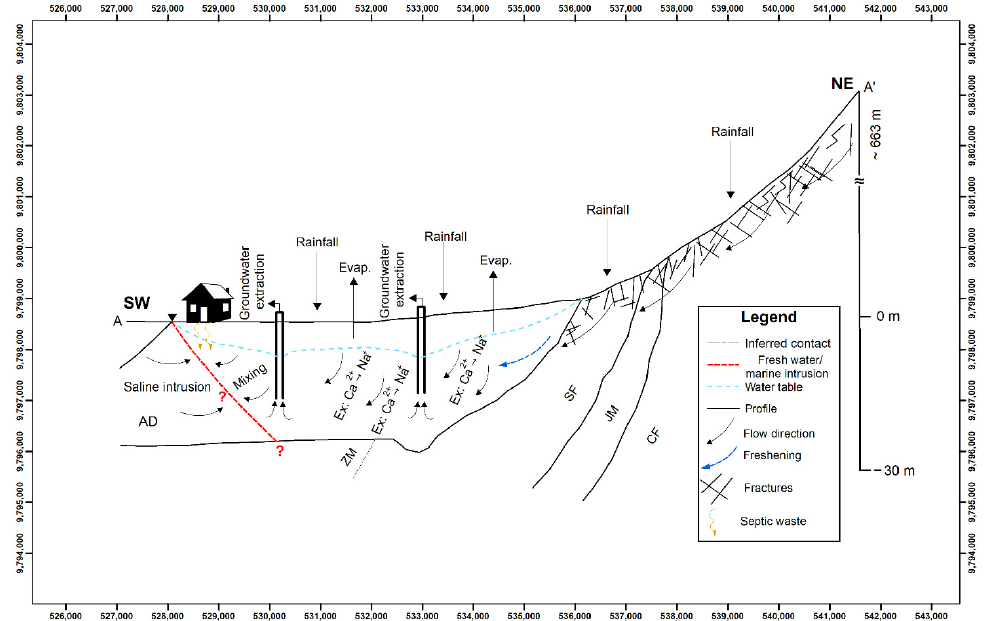
Figure 8. The conceptual hydrogeological model of the Manglaralto river basin based on stable isotope and hydrochemical techniques, showing processes of direct cation exchange, mixing, freshening, recharging, evaporation, and pollution. AD: Alluvial Deposit; ZM: Zapotal member; SF: Socorro formation; JM: Javita member; CF: Cayo